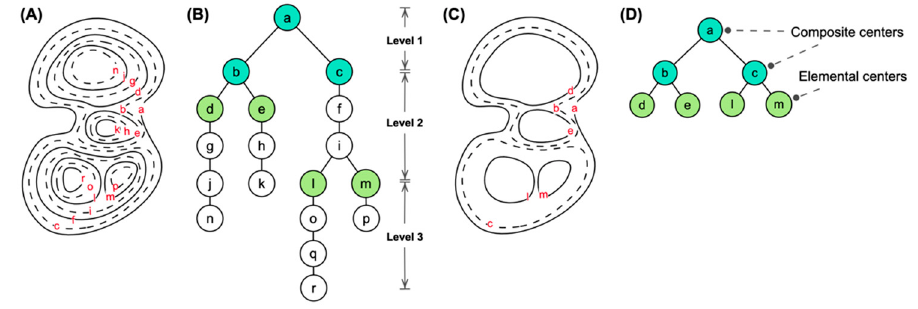
Figure 5. Simplification of the contour tree. ( A ) Original contour line; ( B ) Original contour line tree; ( C ) Simplified contour line; ( D ) Simplified contour line tree.